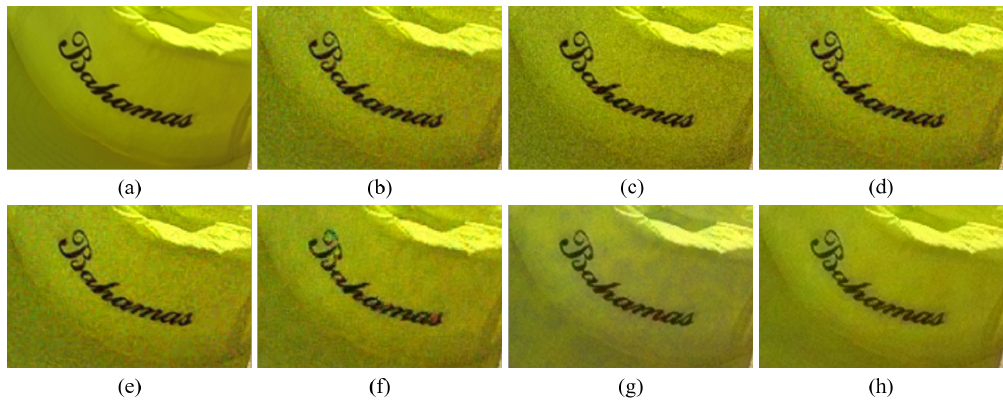
Figure 5. Showing the enlarged regions of Figure 4. ( a ) Original ( b ) ICC [12], ( c ) DNet [13] ( d ) RI